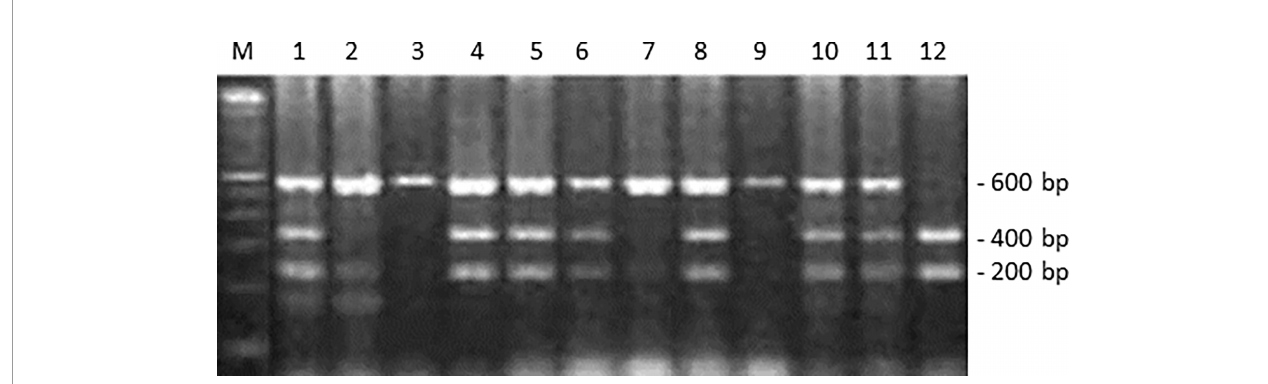
FIGURE 1 | ITGA2 polymorphism genotyping by PCR-RFLP assay. This panel shows the Bgl II digestion of ITGA2 gene PCR products. Lane M: 100-bp molecular marker. Lanes 2, 3, 7, and 9 are representative of a homozygote -/- (absence of Bgl II site); lanes 1, 4, 5, 6, 8, 10, and 11 of a heterozygote -/+; and lane 12 of a homozygote polymorphic +/+ (presence of Bgl II